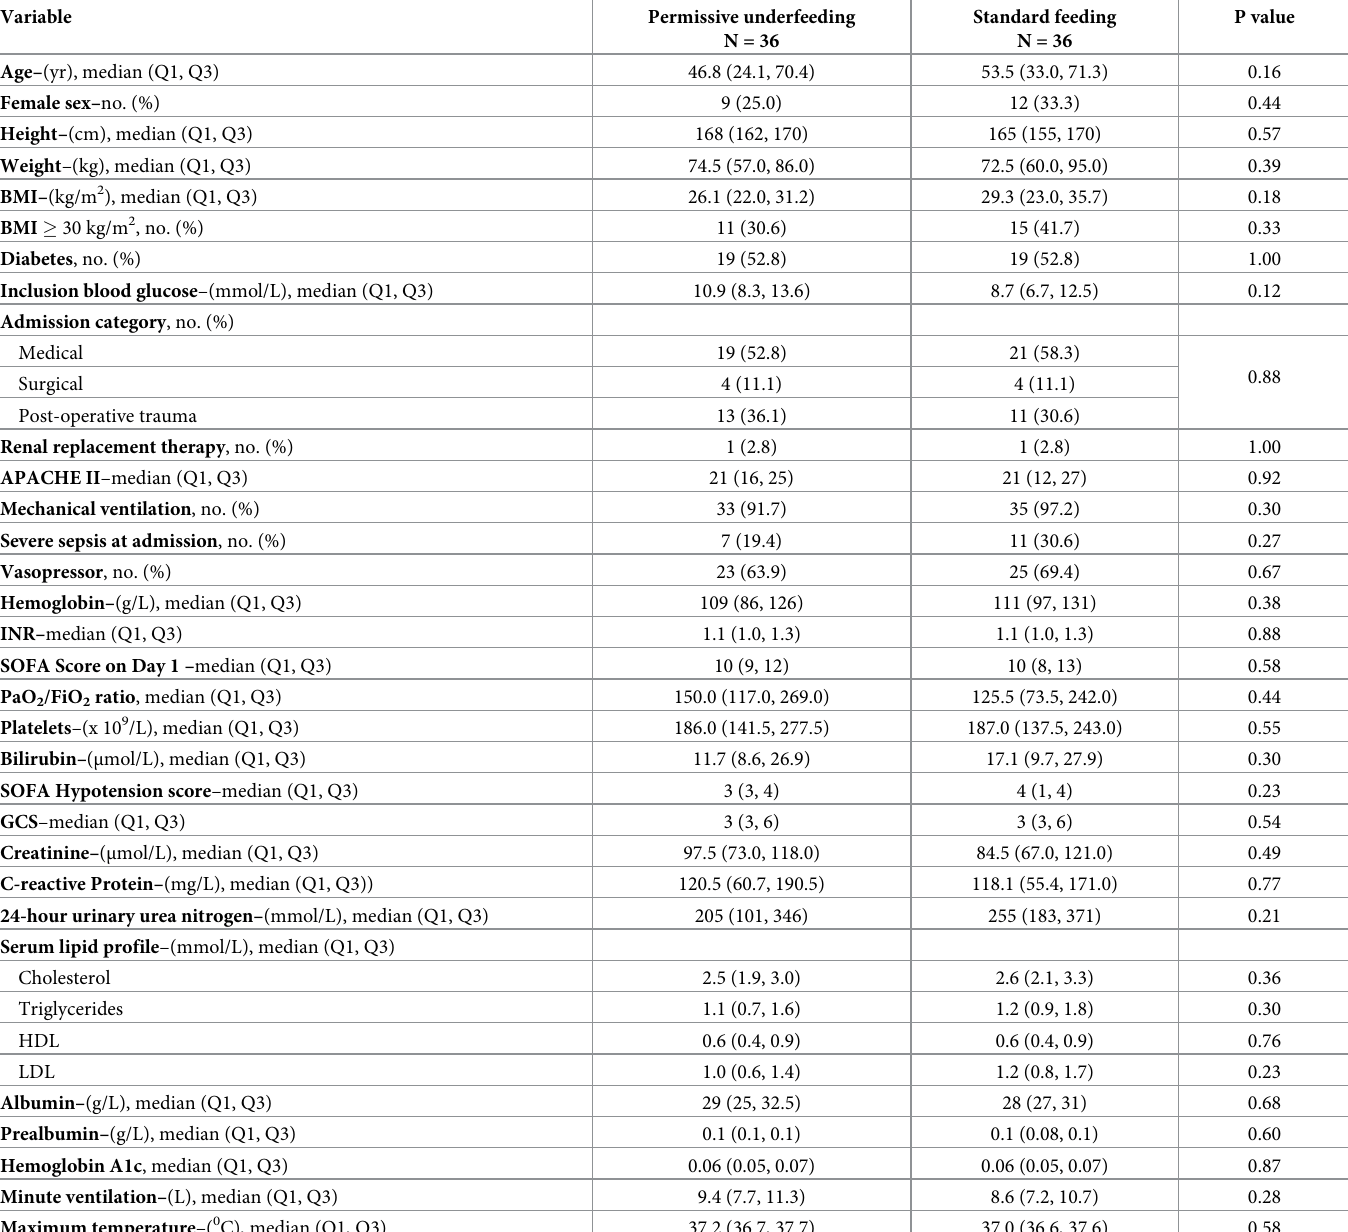
Table 1. Baseline characteristics of patients in the permissive underfeeding and standard feeding.